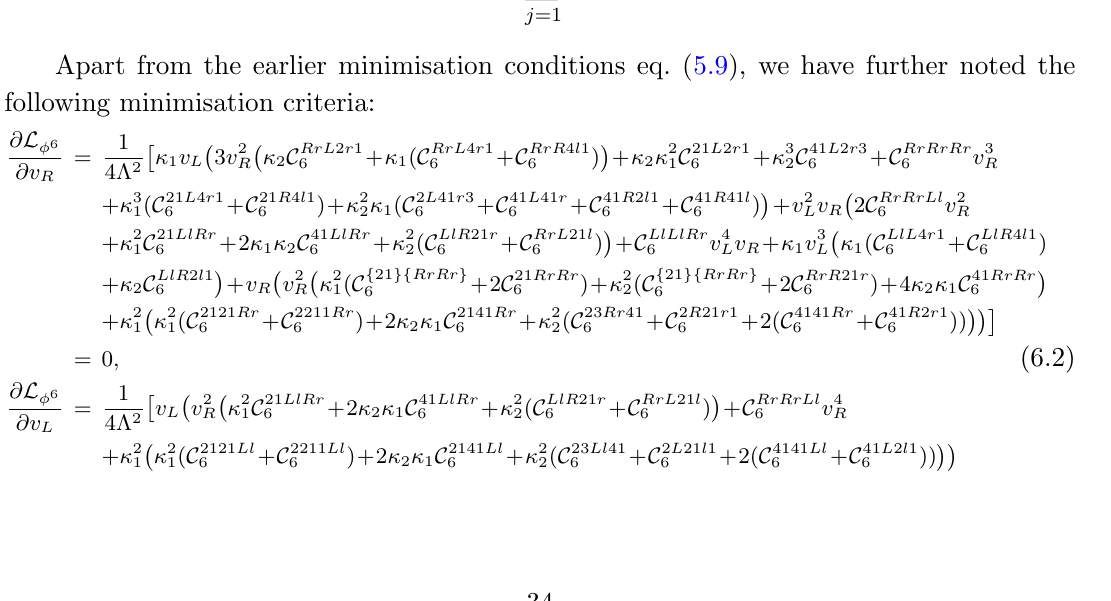
2 = 36], (d) (cid:30) 4 D 2 [20 + 11 (cid:2) 2 = 72] (Dirac type), (cid:2)